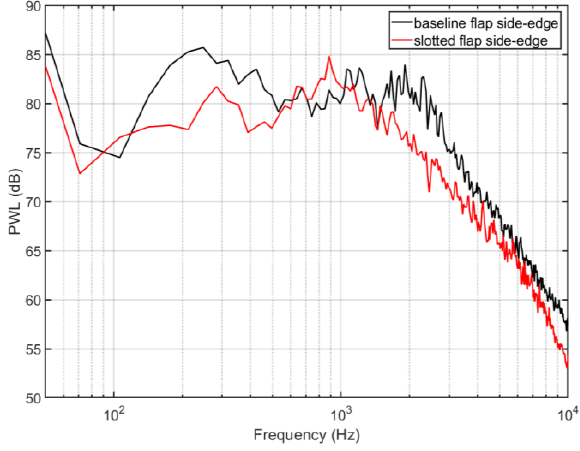
Figure 17. The comparison of the sound power level (PWL) between the baseline flap side-edge and the slotted flap side-edge.